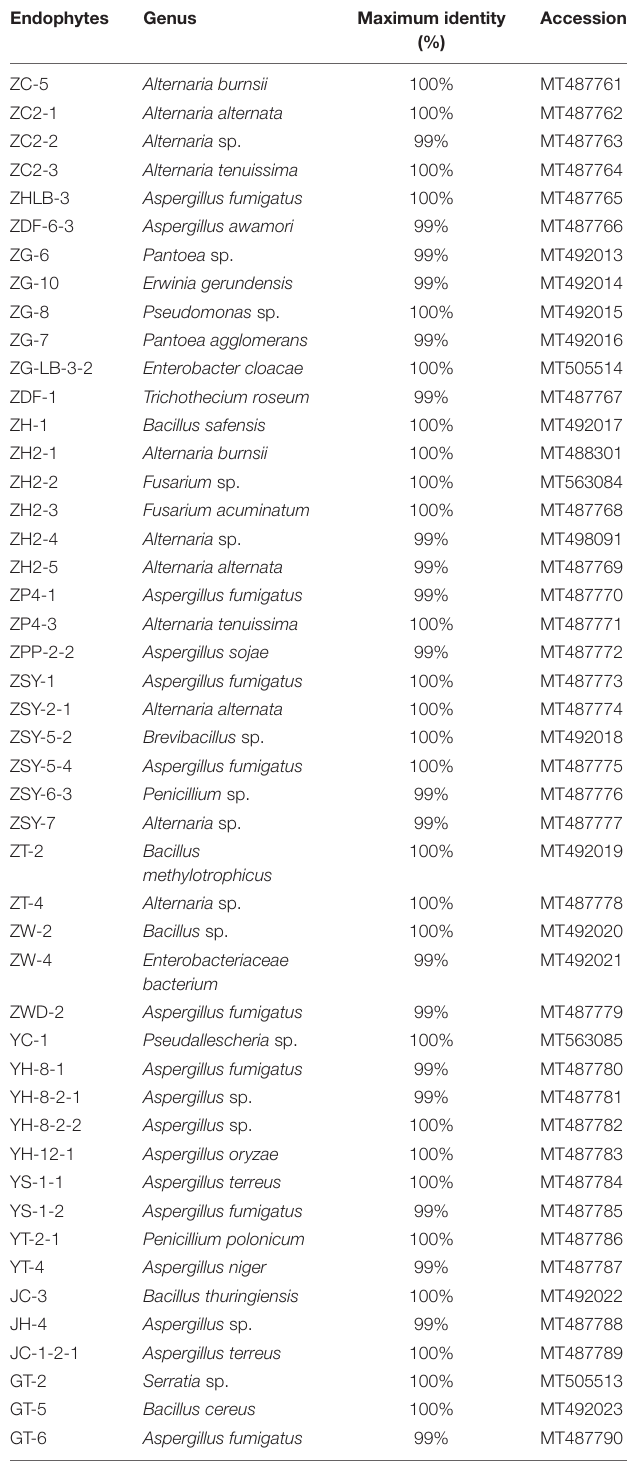
TABLE 2 | Endophytes isolated from different tissues of A.